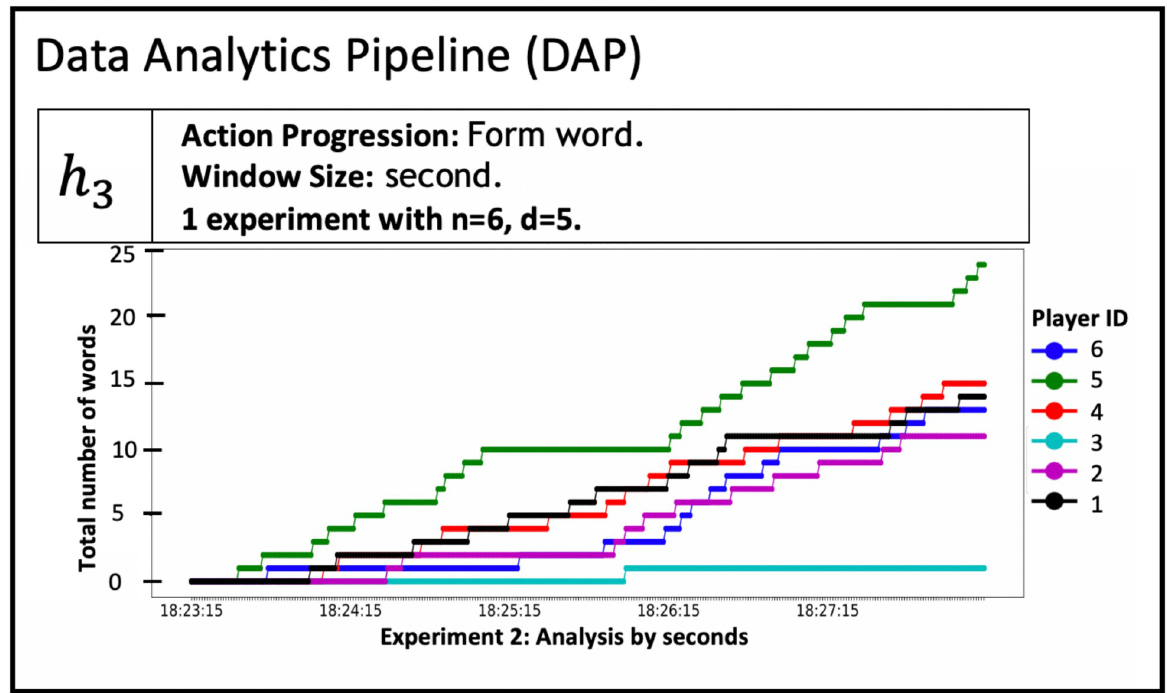
Fig 14. The Data Analytics Pipeline (DAP) was executed to analyze phase 2 of three experiments with n = 6 and d = 5. The time series of number of words formed by player for experiment #2 is generated by function h 3 . https://doi.org/10.1371/journal.pone.0242453.g014 construct the time series for any action. These data, and the data generated by h used to ( i ) understand player behaviors, ( ii ) help in idetifying the structure of ABMs, ( iii ) infer properties of ABMs, and ( iv ) assist in models validation with the comparison of model predic- produces the data needed for property inference and showed in Fig 16. tions. Function h 7